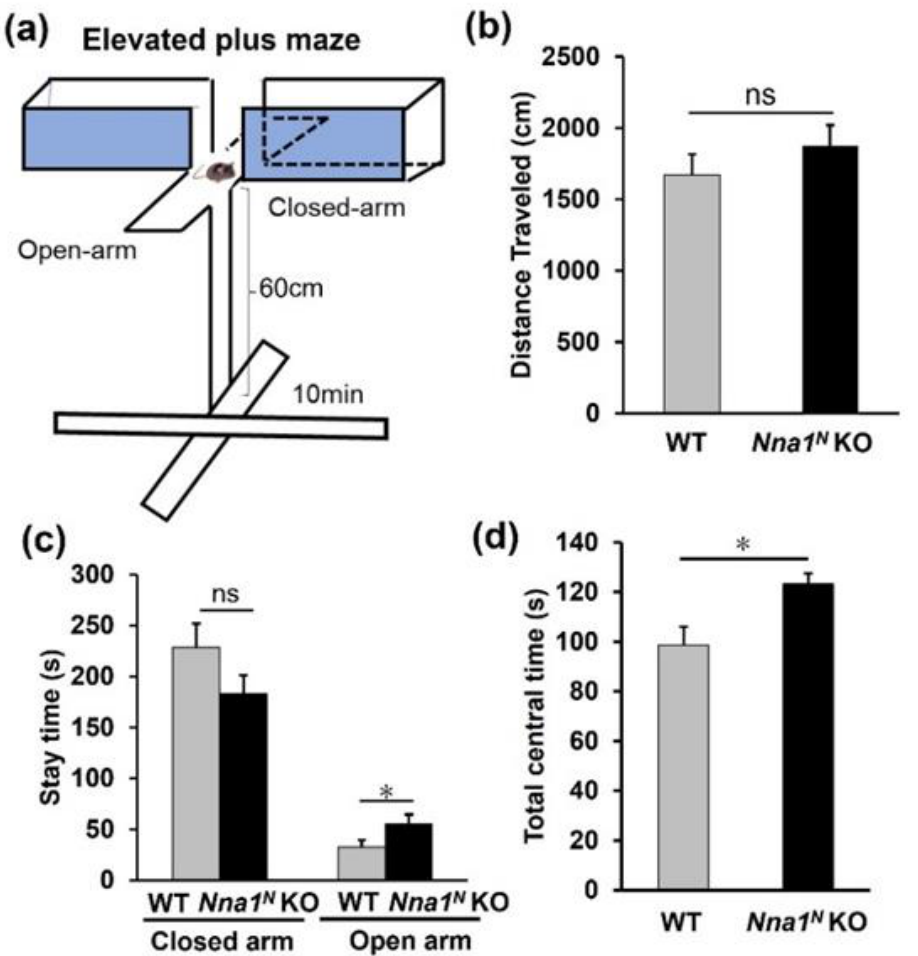
Figure 5. Anxiety-related behavior in Nna1 N KO mice observed by the elevated plus maze test. ( a ) Schematic representation of the elevated plus maze test. ( b ) No significant difference was observed between Nna1 N KO mice and WT ones in the total distance traveled. ( c ) Nna1 N KO mice spent longer time in the open arm compared with WT mice. However, no significant difference in the time spent in the closed arms between KO and WT mice. ( d ) Nna1 N KO mice showed more stay time in the central region than the WT ones. WT, n = 6; Nna1 N KO, n = 10, * p < 0.05, Student’s t -test. All values presented are means ± SEM. “ns” means not significant.